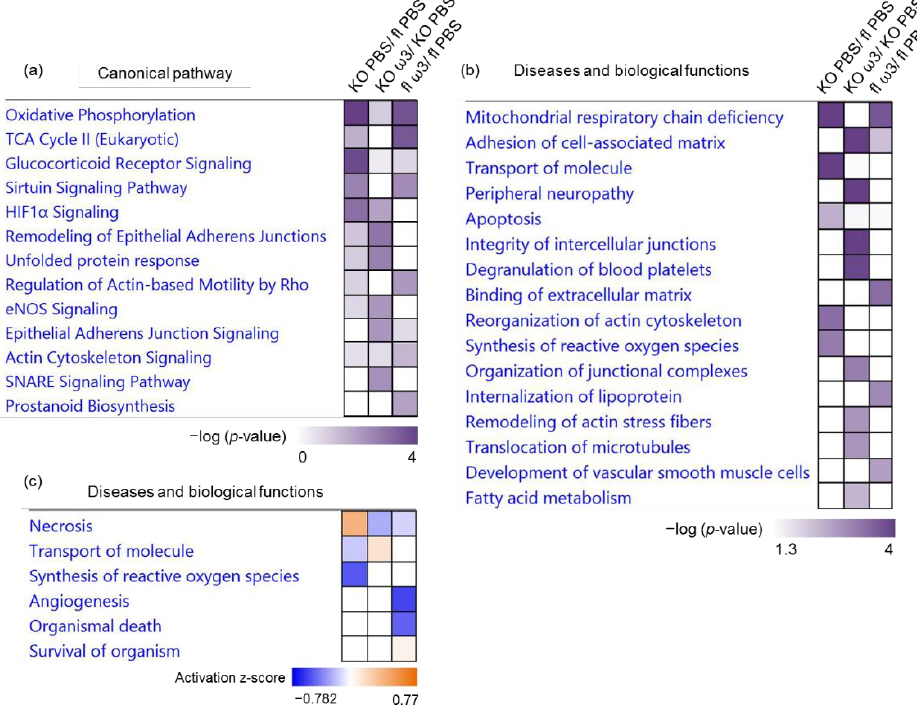
Figure 3. Top significantly enriched canonical pathways and diseases and biological functions in the ophthalmic artery. ( a ) The significantly enriched canonical pathways implicated in the ophthalmic artery, which were determined by p -value overlap between the proteins identified in our datasets and the molecules in the respective pathways. The significance of enrichment ( − log10 ( p -value), one-sided Fisher’s exact test)) is scaled by colour intensity; p < 0.05. The clustering of the most significantly affected diseases and biological functions in the ophthalmic artery depicted according to the ( b ) − log10 ( p- value) and ( c ) activation z-score. Overall z-scores are represented by the colour orange, which indicates activation, and blue indicates inhibition of the signalling